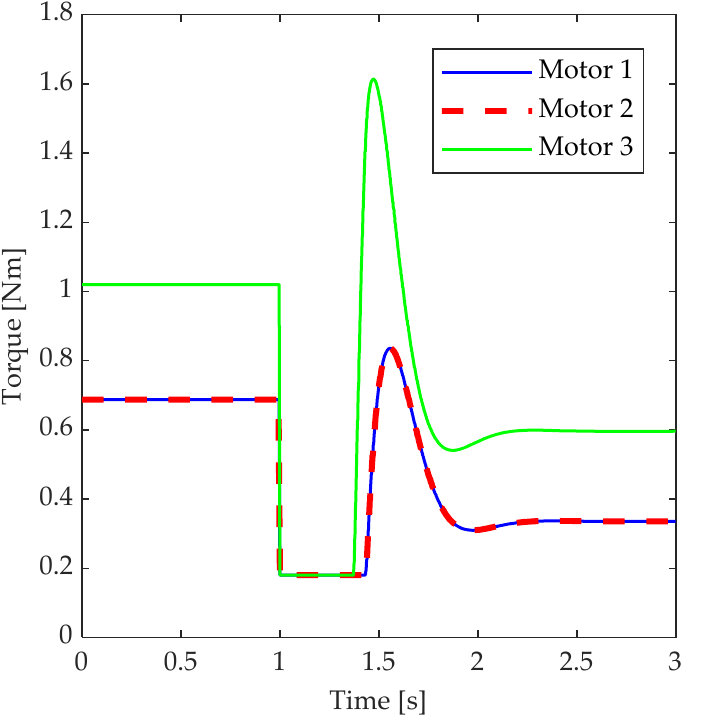
Figure 5. Time histories of the motor torques.